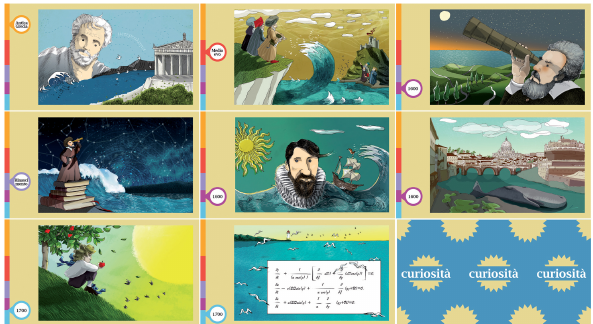
Figure 7. The curiosity cards, if extrapolated from the game, can be used as a comics book, a graphic–artistic tale of the history of the scientific tide theory evolution (illustration made by Francesca di Laura from INGV Laboratorio di Grafica e Immagine, graphic